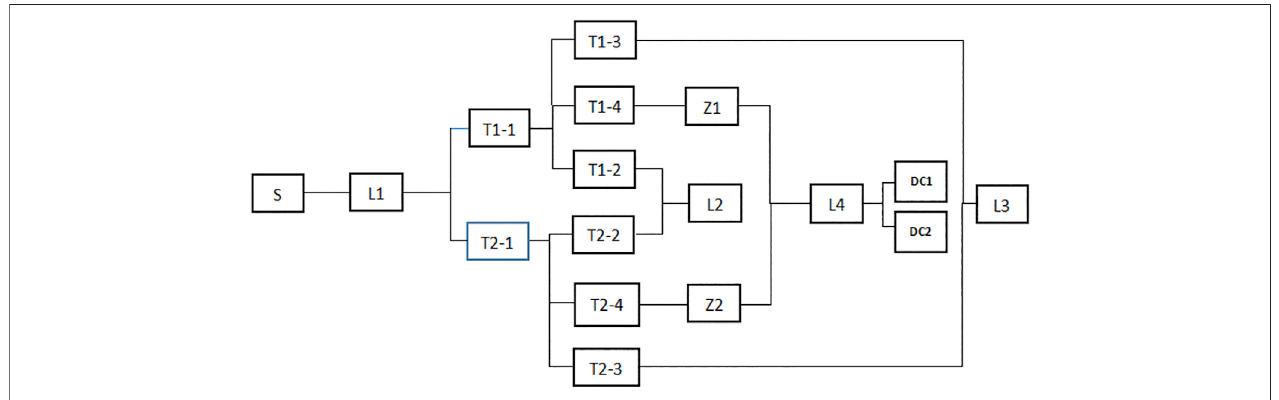
FIGURE 14 | Reliability block diagram of two-station four-port PET clusters unit.